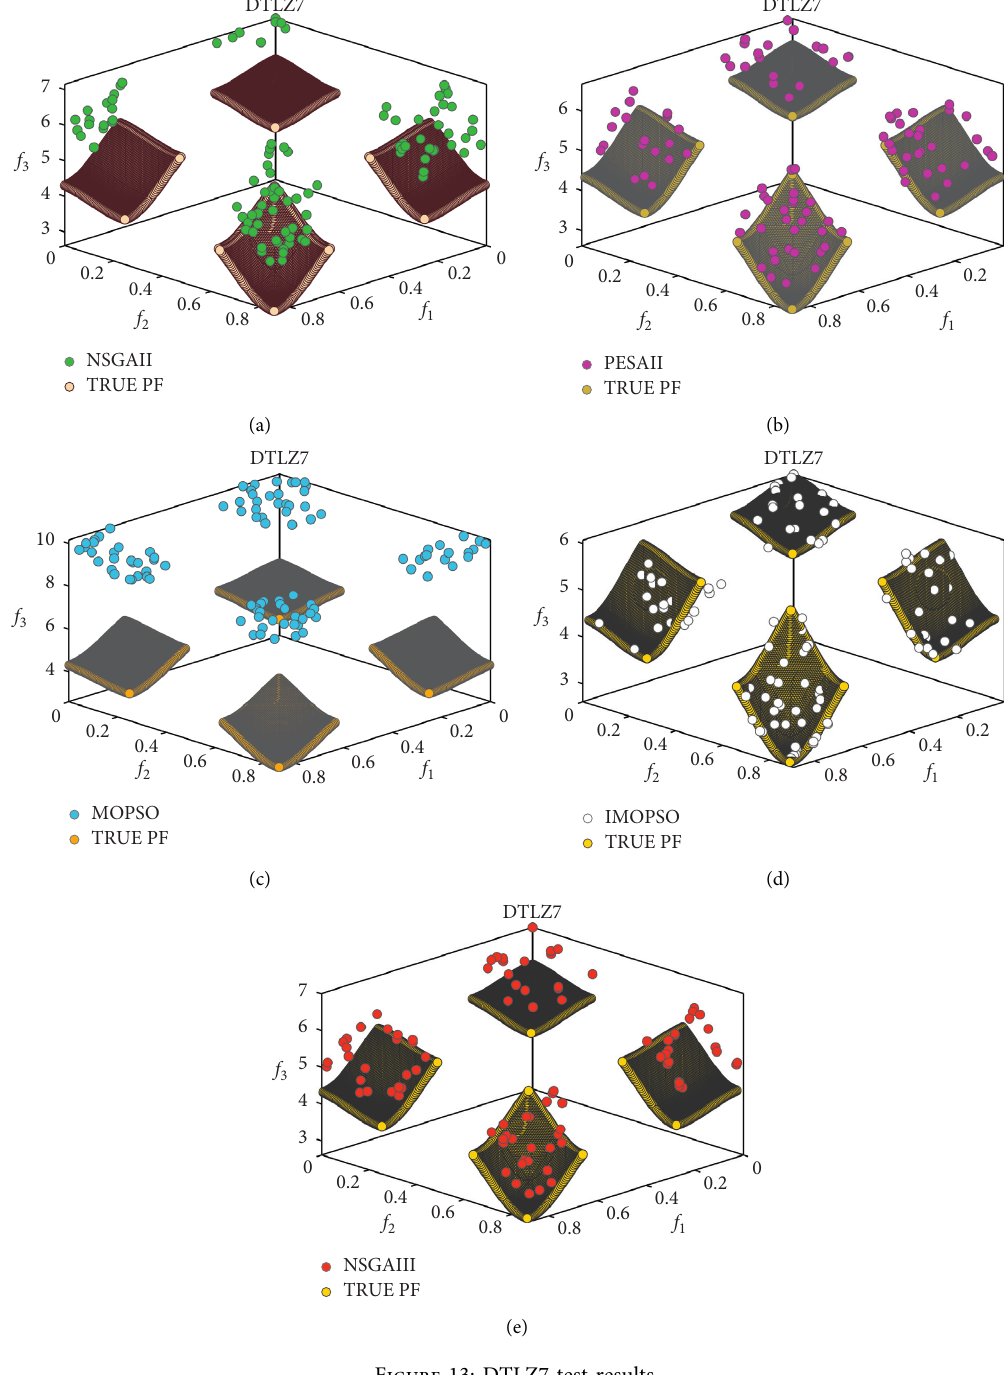
Figure 13: DTLZ7 test